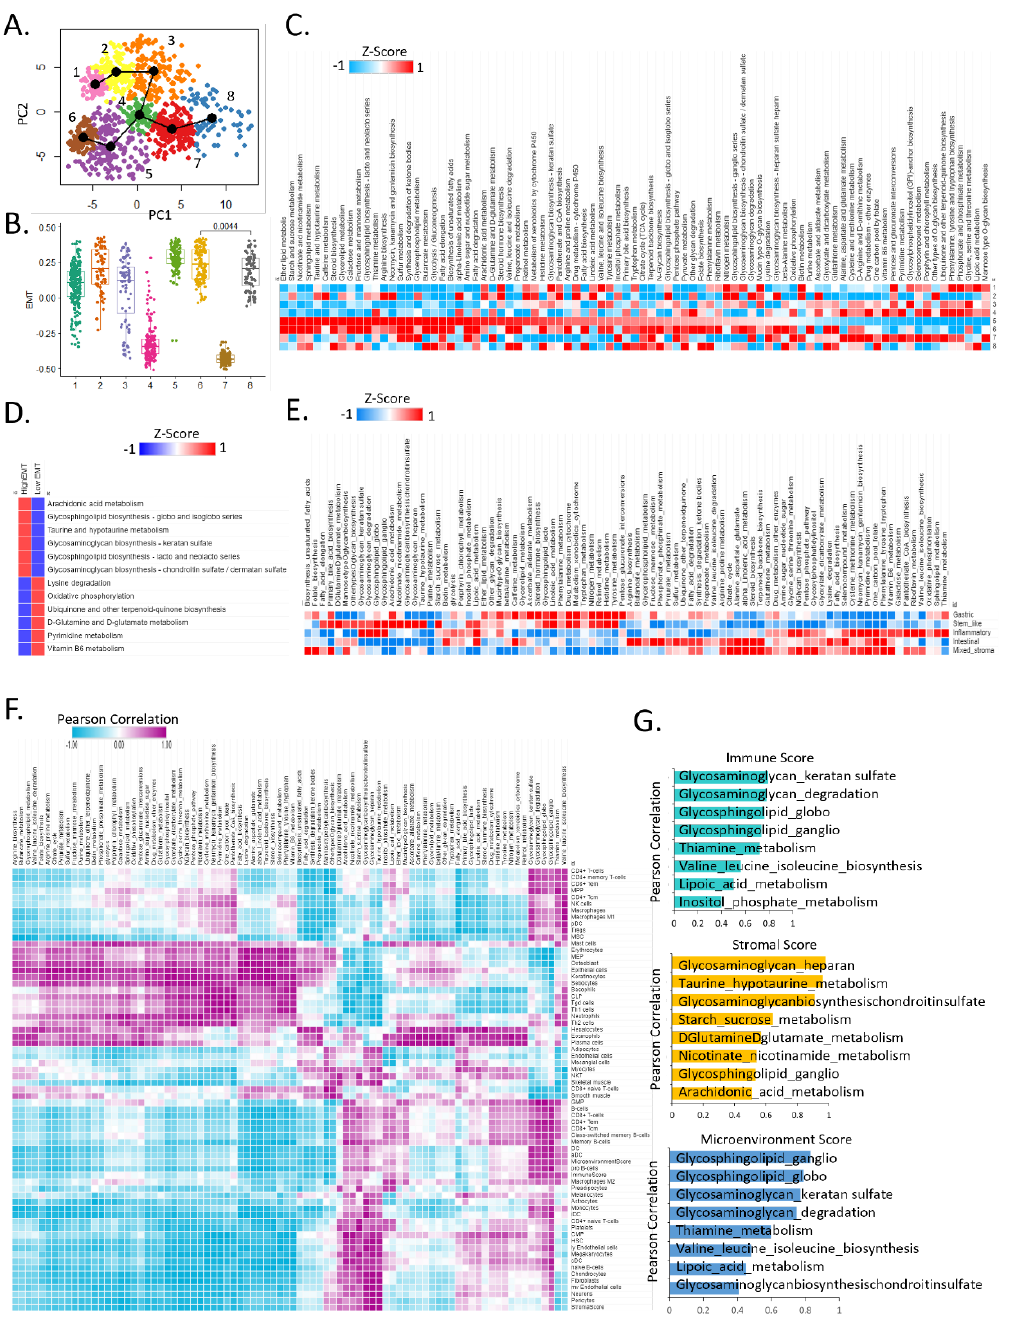
Figure 3. Comparison of intratumoral metabolic heterogeneity between adenocarcinoma cells and bulk samples. ( A ) Adenocarcinoma lineage plot adenocarcinoma single cells from the gastric tumor dataset. ( B ) Boxplot of EMT score for eight adenocarcinoma clusters. ( C ) Heat map of 84 metabolic pathways for clustering adenocarcinoma cells. ( D ) Heat map of top six enriched metabolic pathways between high EMT and low EMT. ( E ) Heat map of 84 metabolic pathways for molecular subtype of gastric cancer (497 Yonsei Hospital patients). ( F ) Heat map of Pearson correlation with 84 metabolic pathways and 64 cell types from bulk samples (purple: positive correlation, blue: negative correlation). ( G ) Bar graph of the immune score, stromal score, and microenvironment score using correlation coefficient